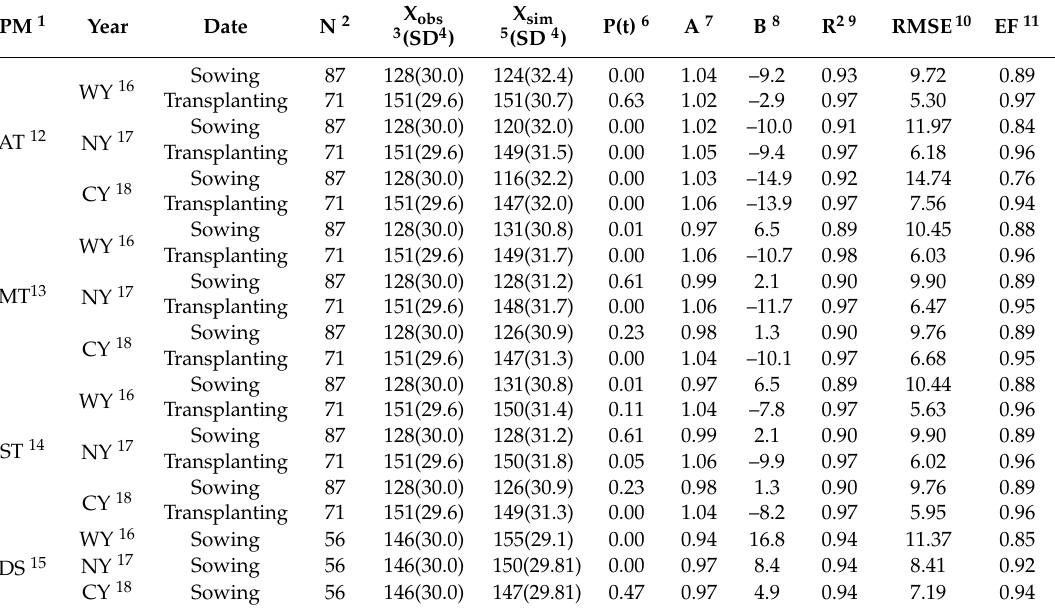
Table 7. Evaluation results of the rice model system across di ff erent